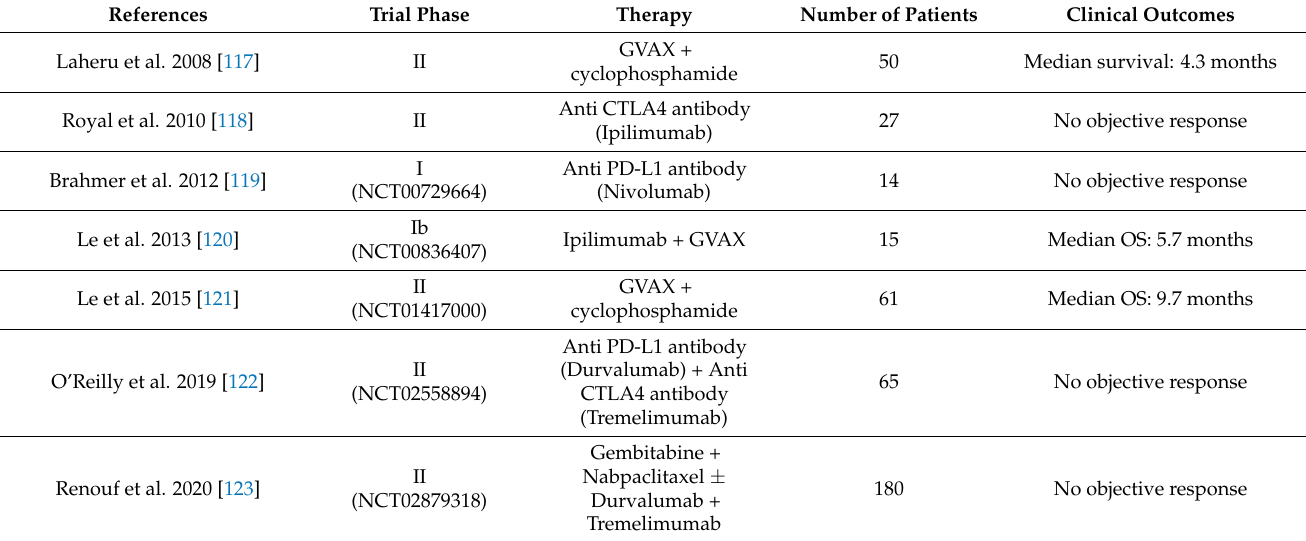
Table 3. Studies assessing immune checkpoint inhibitors in advanced pancreatic ductal adenocarci-